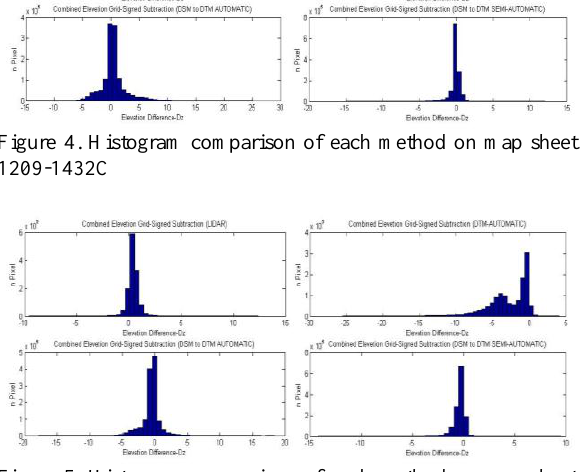
Figure 5. Histogram comparison of each method on map sheet